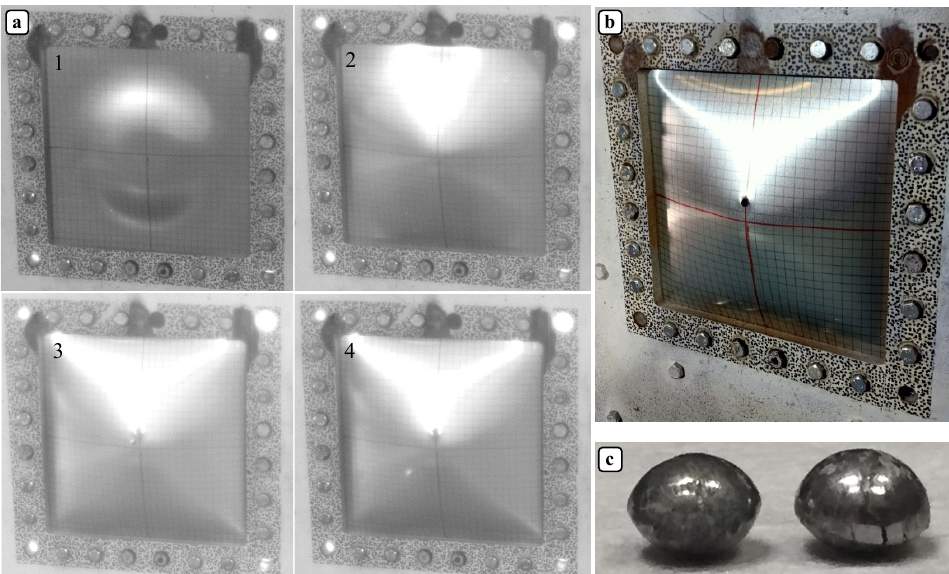
Figure 14. ( a ) Images from HSC2 showing the plate deformation at different time steps and the projectile perforation resulting from the explosion of 10 g of C4 at the entrance of the EDST (Video S3), ( b ) projectile impact point in the plate giving insights about its trajectory inside the EDST, ( c ) features of the projectiles after